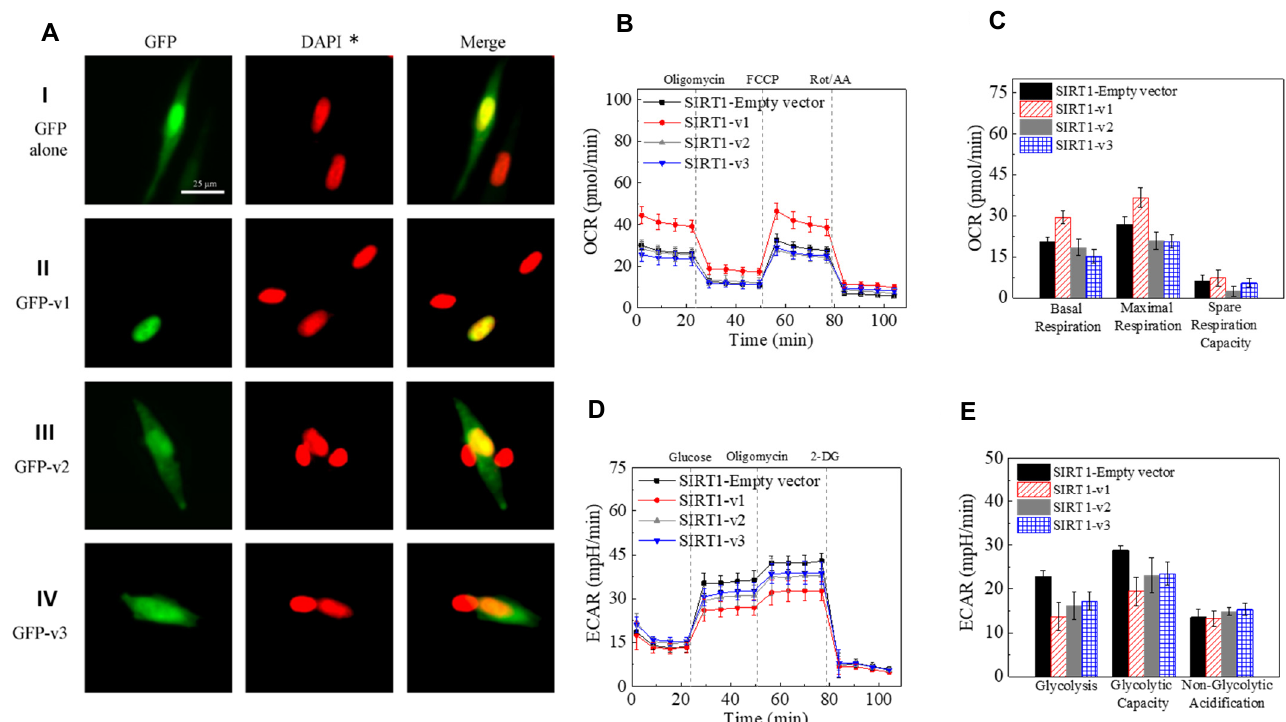
Figure 4. SIRT1 isoforms localization and functions. ( A ). Intracellular localization of GFP-SIRT1-v1, v2, and v3 fusion proteins in SH-SY5Y cells. GFP protein alone was shown in cytoplasm. GFP-v1 isoform protein was shown in nucleus. GFP-v2 protein was shown in cytoplasm. GFP-v3 isoform protein was shown in cytoplasm. The original DAPI was in blue color, the DAPI* here refers to the pseudo-color (red) that was converted from blue to red color using Nikon NIS-Elements Imaging Software. ( B , C ). SIRT1-v1 significantly increased the oxygen consumption rate (OCR) in term of basal respiration ( p < 0.01, n = 3) and maximal respiration ( p < 0.01, n = 3) compared to empty vector. Both SIRT1-v2 and v3 isoforms slightly reduced OCR compared with control (NS, n = 3). ( D , E ). The SIRT1-v1 significantly reduced glycolysis and glycolytic capacity compared with control ( p < 0.01, n = 3). SIRT1-v2 and v3 also reduced glycolysis rate in the cells ( p < 0.05, n = 3).